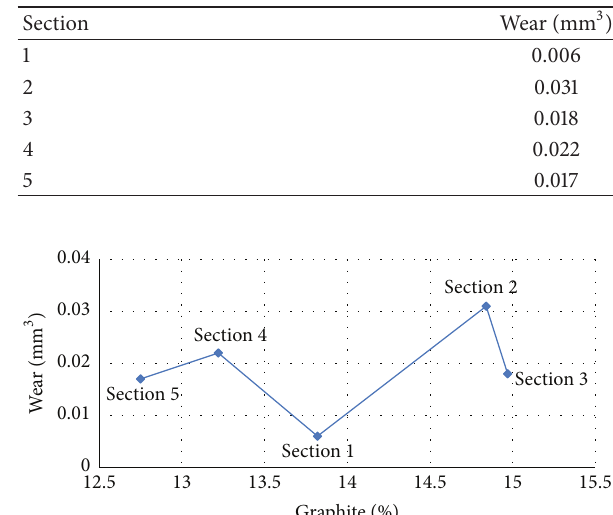
Table 4: Results of the section classifying algorithm. Table 5: Wear test results.